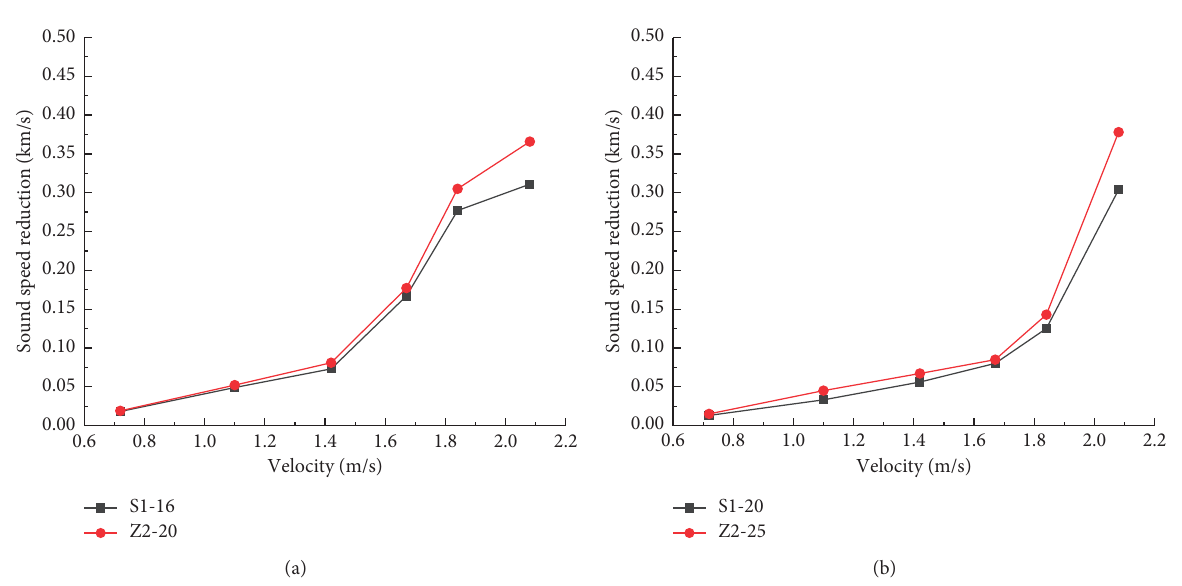
Figure 16: Correlation diagram between ultrasonic velocity reduction and impact velocity.